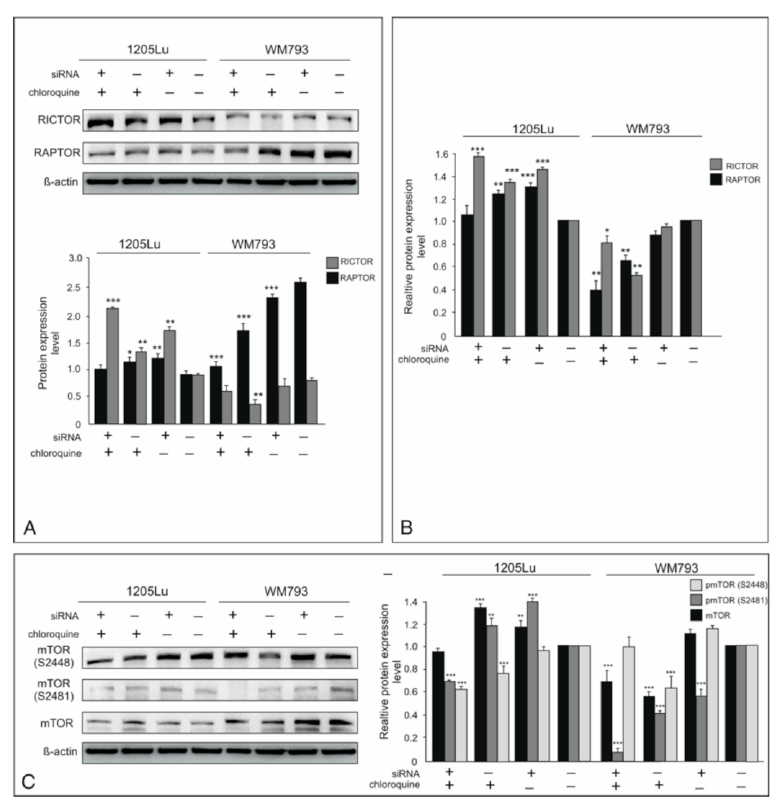
Figure 3. Effect of ILK knockdown and CQ use on mTOR activity. “+” refers to siRNA ILK or chloroquine; “ − ” refers to silencer negative control cells. ( A )—Expression RICTOR and RAPTOR. Representative blots are displayed. The histogram presented protein level expression. ( B )—The histogram presented relative protein expression level after densitometry (mean ± SD) of three independent experiments. β -actin was used as a protein loading control. Asterisks indicate significant differences from control cells. Values are denoted as * p < 0.05, ** p < 0.01, and *** p < 0.001. ( C )—the expression of both phosphorylated and total mTOR. Representative blots are displayed. The histograms are a quantitative representation of data after densitometry (mean ± SD) of three independent experiments. β -actin was used as a protein loading control. Asterisks indicate significant differences from control cells. Values are denoted as * p < 0.05, ** p < 0.01, and *** p <